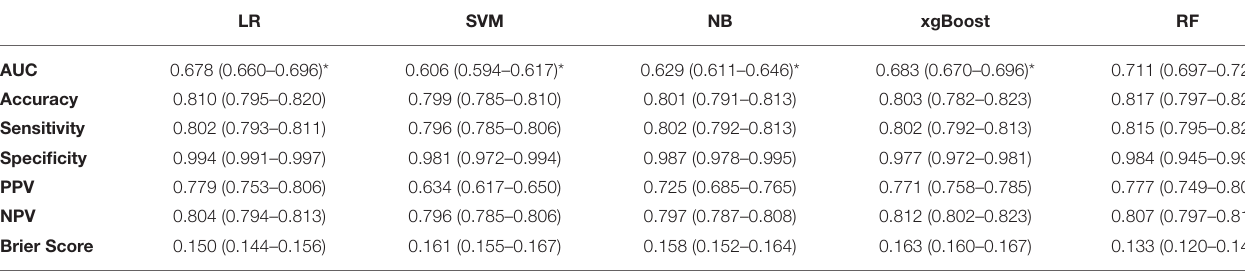
TABLE 3 | Comparison of prediction results of five test models using test data